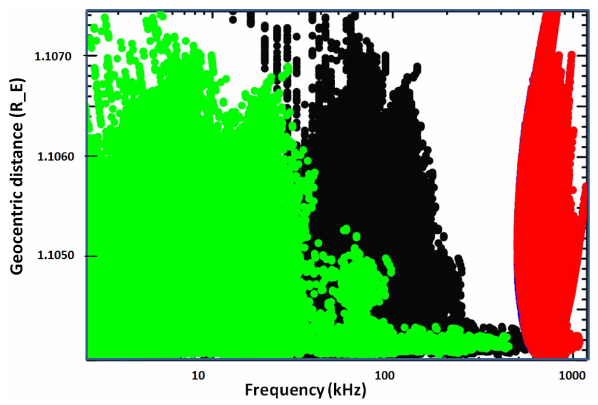
Figure 10. Variations of the frequency-banded emission versus the geocentric distance expressed in R E . The green, black and red are associated, respectively, with f z , f p and f g